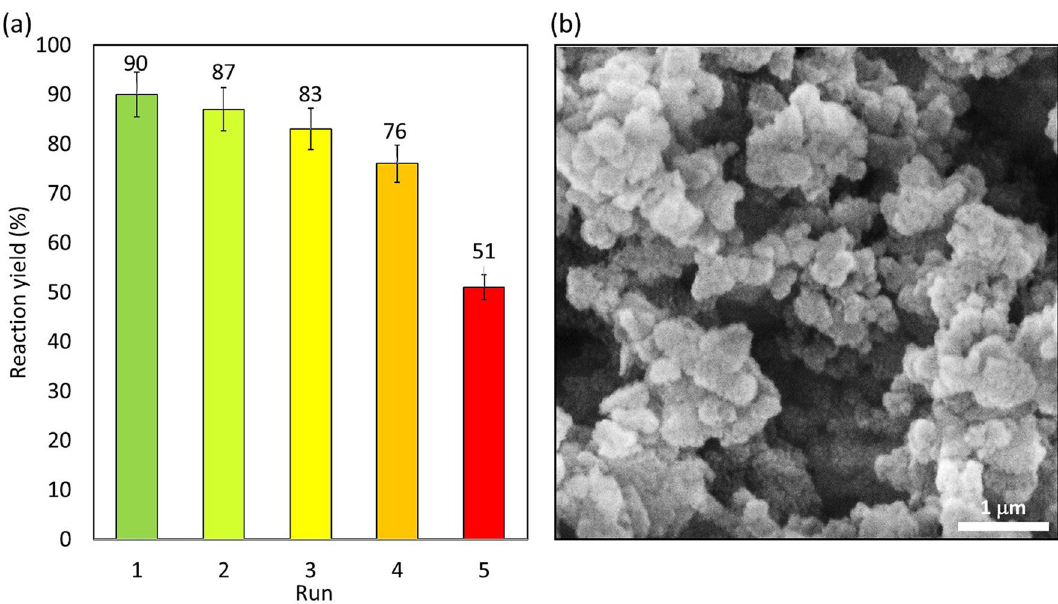
Figure 8. ( a ) Recyclability investigation of Fe 3 O 4 @SiO 2 /TABHA NPs in catalyzed peptide coupling reactions. The results were obtained from the coupling reaction between Fmoc-Phe-OH and methyl glycinate, per 0.2